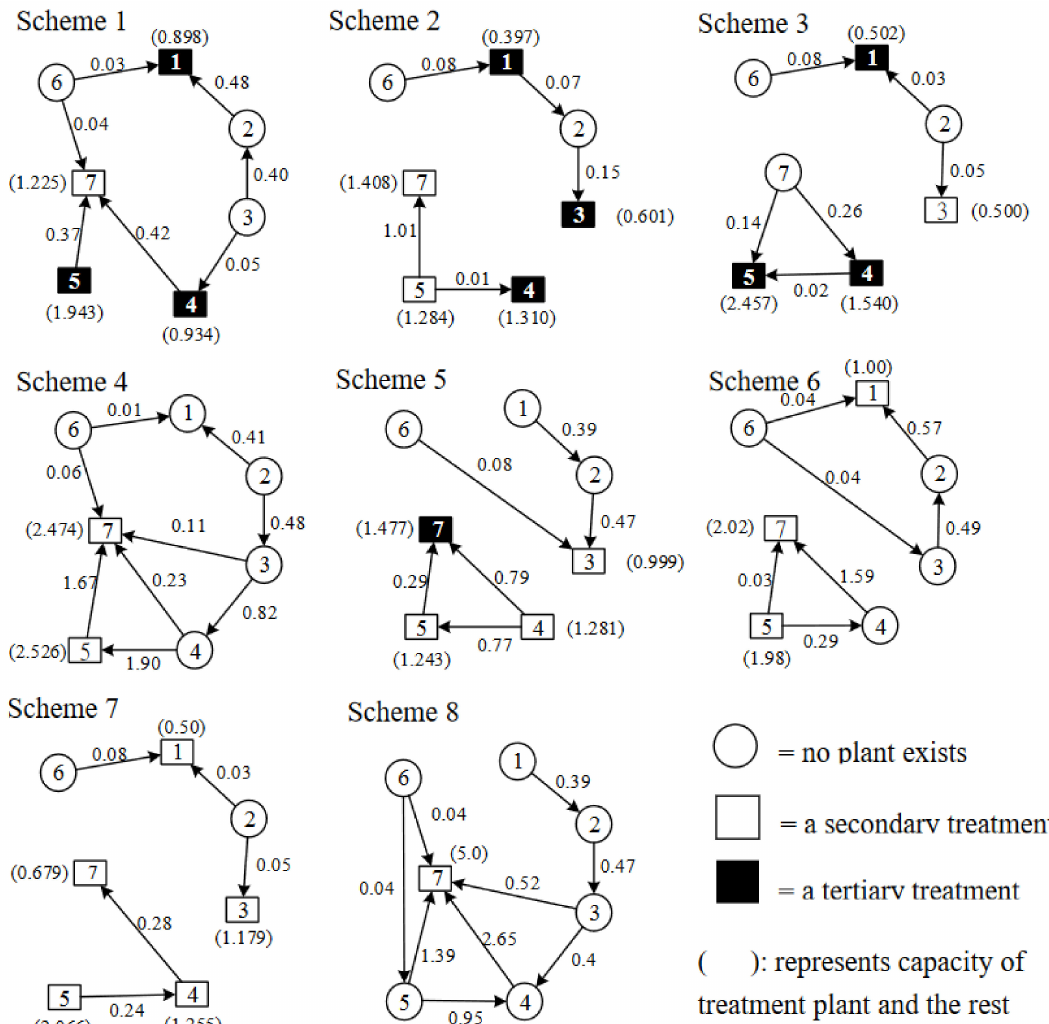
Figure 8. Graphical solution of Schemes